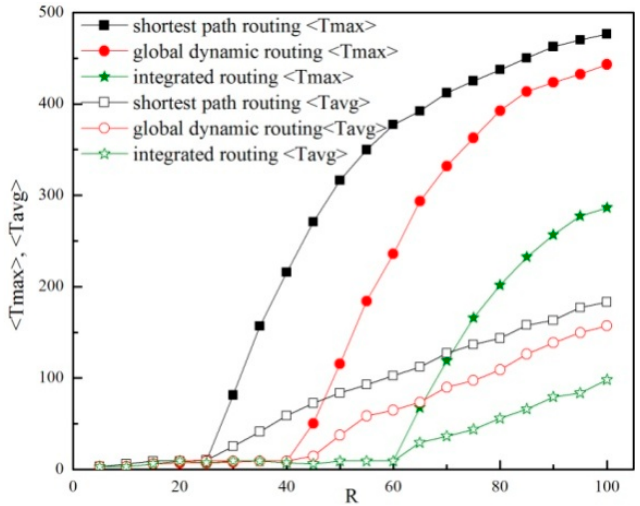
Figure 15. The maximum transmission time <Tmax> and average transmission time <Tavg> vs. packet generation rate R under different routing strategies.